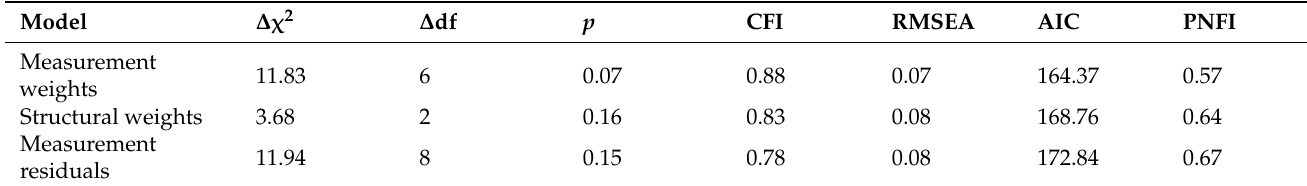
Table 6. Comparison of models